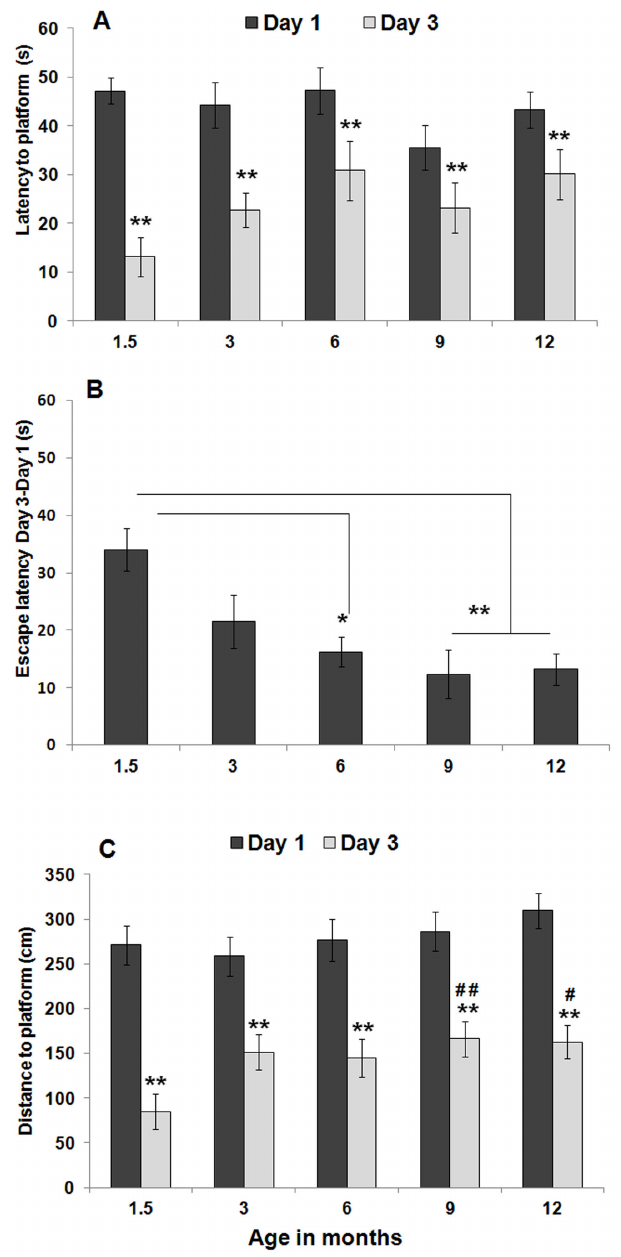
Figure 5. Learning of the MWM task is only modestly affected by age. C57BL/6J male mice with 1.5, 3, 6, 9, and 12 months of age were tested in the MWM for their ability to learn and recall the location of a hidden platform. (A) Time required to find the hidden platform (i.e., escape latency) in both days 1 and 3 of the MWM training. For all age groups, escape latency on day 3 of training was significantly reduced when compared with escape latency on day 1, indicating that all mice were able to learn the task. (B) When the average time required to locate the hidden platform on day 3 was subtracted from that of day 1, a significant effect of ageing on the ability to learn the MWM task was observed, with older animals taking longer to learn the location of the hidden platform. ( C ) Distance traveled to find the hidden platform (i.e., path length) in both days 1 and 3 of the MWM training. For all age groups, path length on day 3 of training was significantly reduced when compared with the respective path length on day 1, further indicating that all mice were able to learn the task. However, on day 3 of training, 1.5-month old mice swam significantly less than their oldest counterparts. Data are presented as means ± SEM. ** p < 0.01, when comparing day 1 and day 3 of training for each age group; # p < 0.05, when comparing the distance traveled on day 3 of training between 1.5- and 9-month old mice; ## p < 0.01, when comparing the distance traveled on day 3 of training between 1.5- and 12-month old mice; see text for additional statistical details. doi: 10.1371/journal.pone.0075125.g005 PLOS ONE |